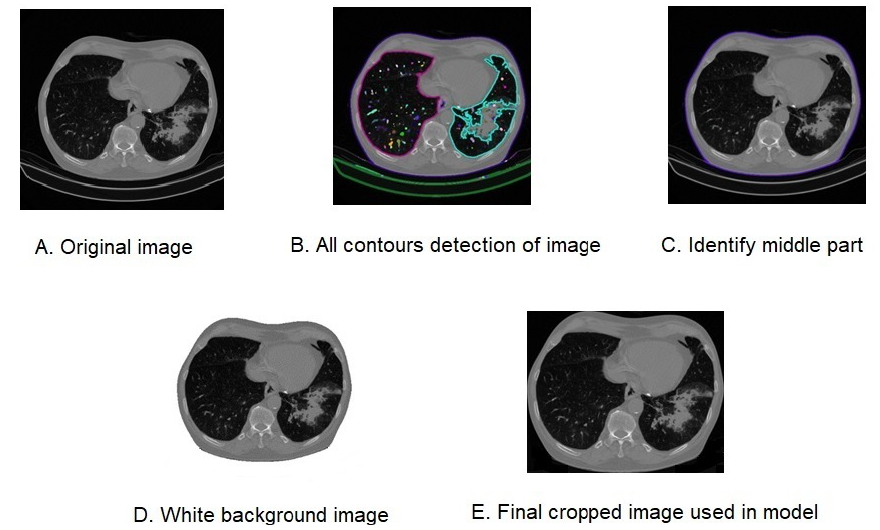
Figure 2. Images Illustrating Various Processing Steps and Outputs. Algorithm 1: Data preparation